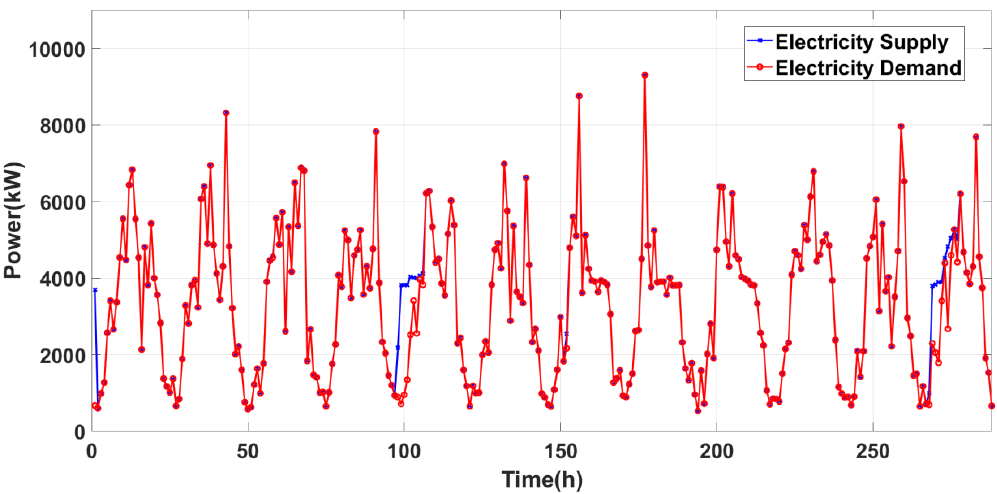
Figure 14. Electricity generation and consumption scenario of Case-02.